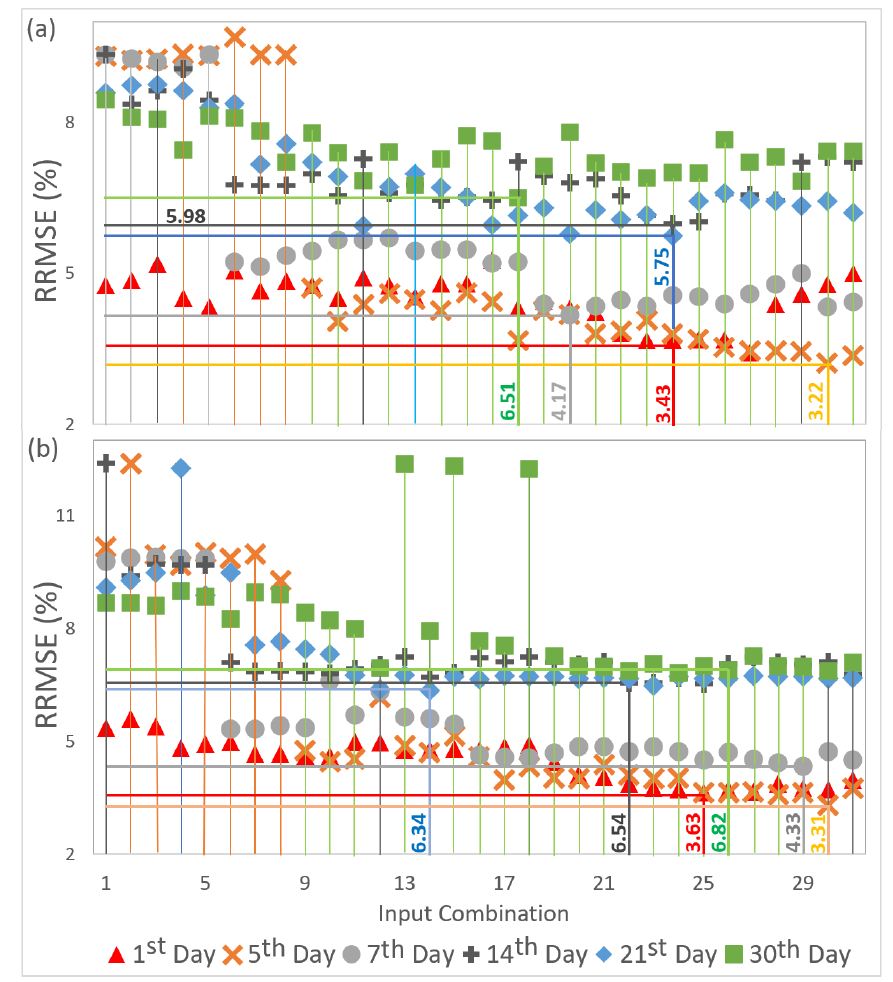
Figure 5. Stair plot showing the relative root mean squared error (RRMSE, %) for ( a ) CNN-GRU and ( b ) GRU applied at different input combinations for the Menindee station at the 1st, 5th, 7th, 14th, 21st and 30th day lead time.